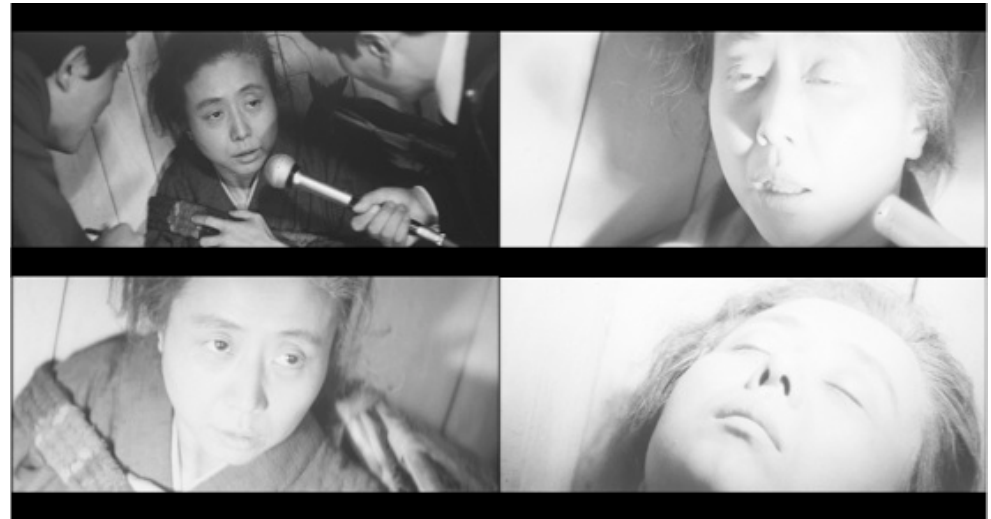
Figure 11. Live Today, Die Tomorrow! (Shind ō Kaneto, 1970).